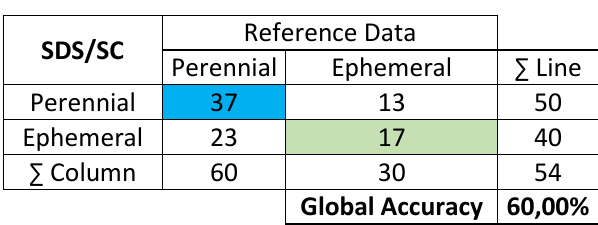
Table 1 – Accuracy Assessment of SDS/SC base in Chapecó.